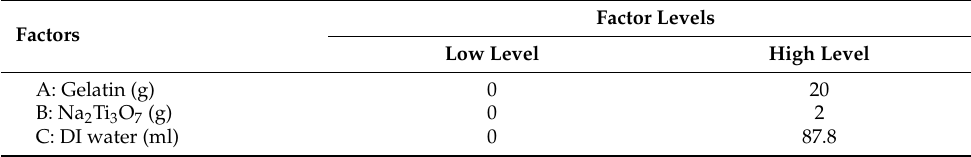
Table 1. List of the raw materials used to synthesize the gelatin/Na 2 Ti 3 O 7 scaffold. Factors